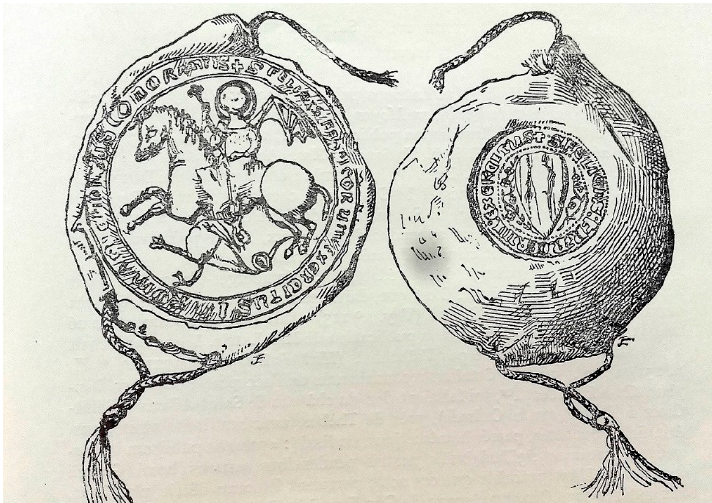
Figure 27. Imprint of the double seal of the Grand Catalan Company, 1312–1214. Source: (Schlumberger et al. 1943, p. 209).